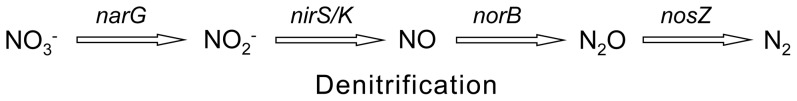
Scheme for nitrogen transformation from NO3
− to N2 by denitrification.Genes encoding enzymes that mediate the denitrification steps include those for nitrate reductase (narG), nitrite reductase (nirS/nirK), nitric oxide reductase (norB) and nitrous oxide reductase (nosZ).